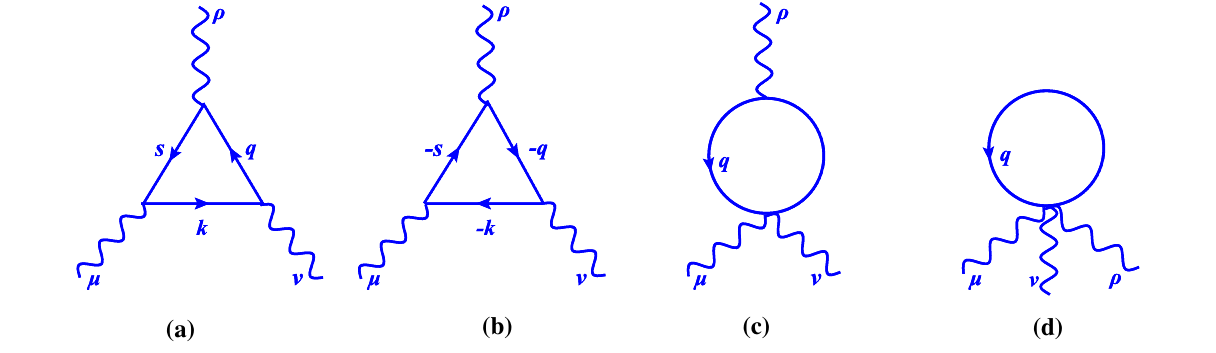
Fig. 3 Relevant graphs for the induced AAA -term